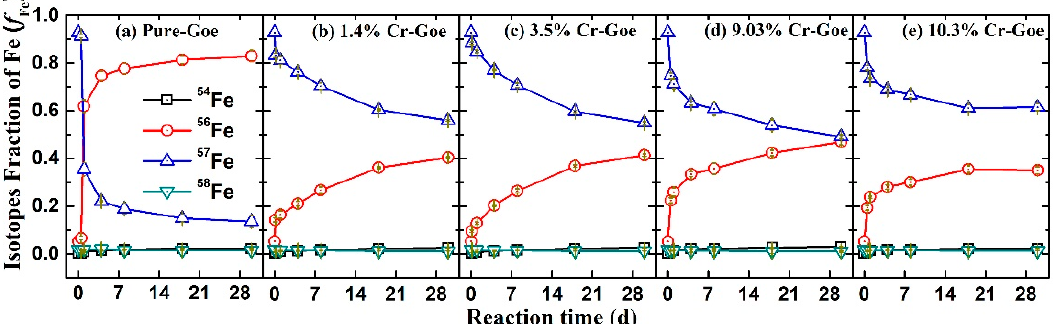
Figure 4. Changes in the four Fe isotopic compositions in aqueous solution during the Fe(II) aq -induced recrystallization of ( a ) pure goethite, ( b ) 1.4% Cr-goethite, ( c ) 3.5% Cr-goethite, ( d ) 9.03% Cr-goethite, and ( e ) 10.3% Cr-goethite. Conditions: [Fe(II) aq ] = 1 mM, [goethite] = 2 g/L, pH 7.5 controlled with 25 mM HEPEs/KBr.